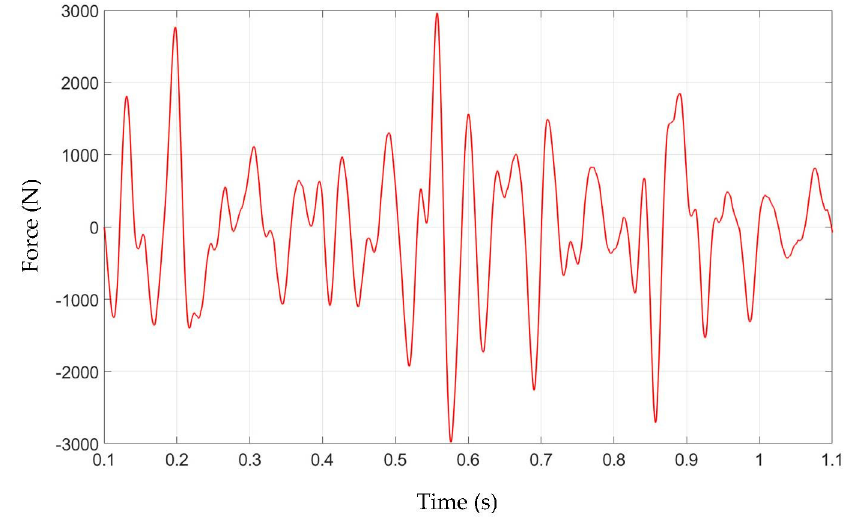
Figure 5. Test rig. 1—electrodynamic shaker, 2—stinger, 3—force sensor, 4—tie rod, 5—Tested EPS.